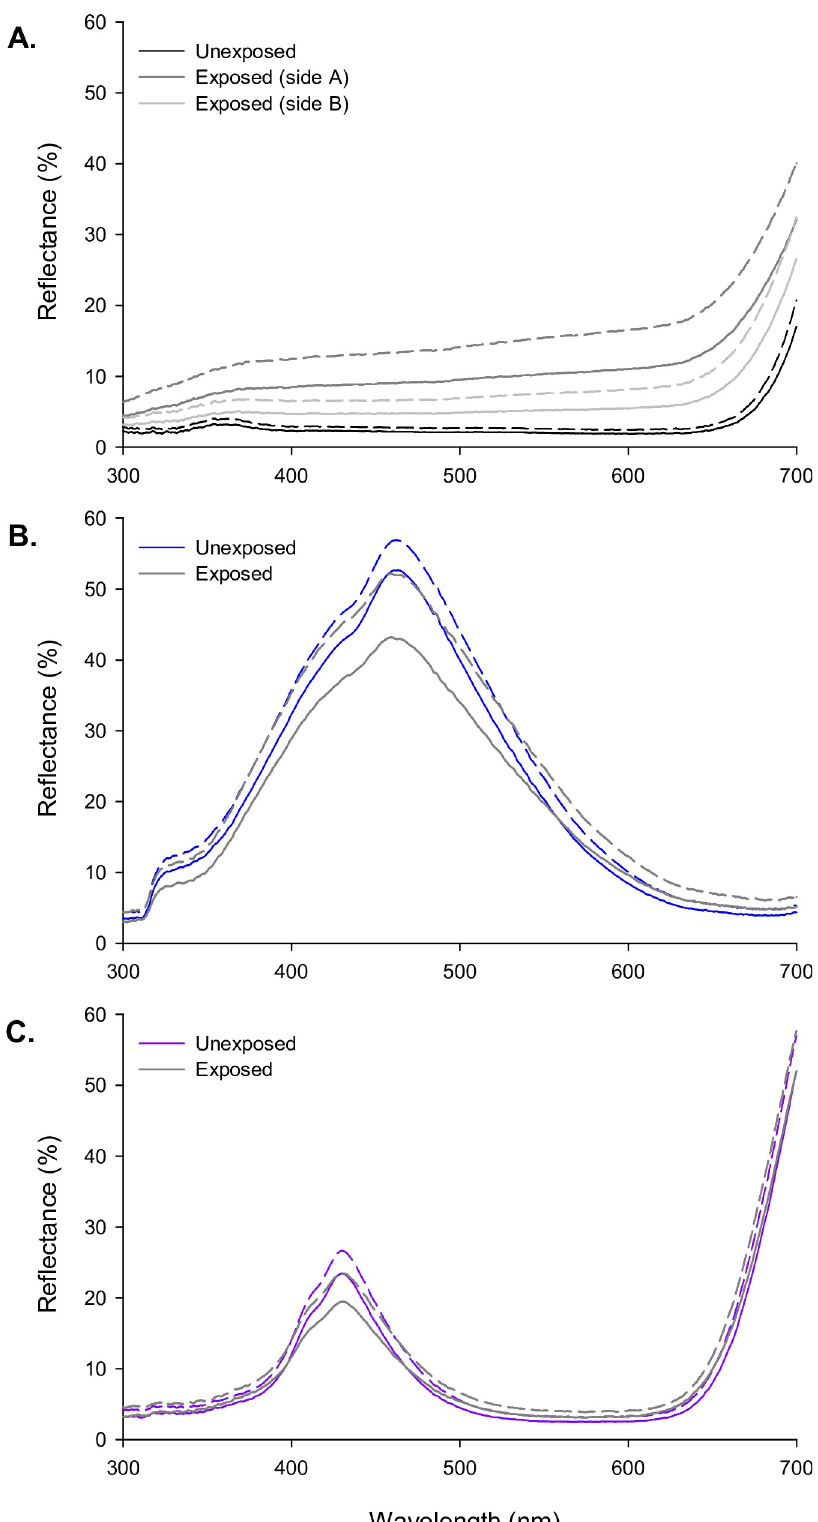
Fig 6. The effect of field exposure on fabric reflectance spectra. (A-C) Each panel shows the reflectance spectra recorded for unexposed (black and coloured lines), and exposed (grey lines) fabric samples. As in Fig 2,